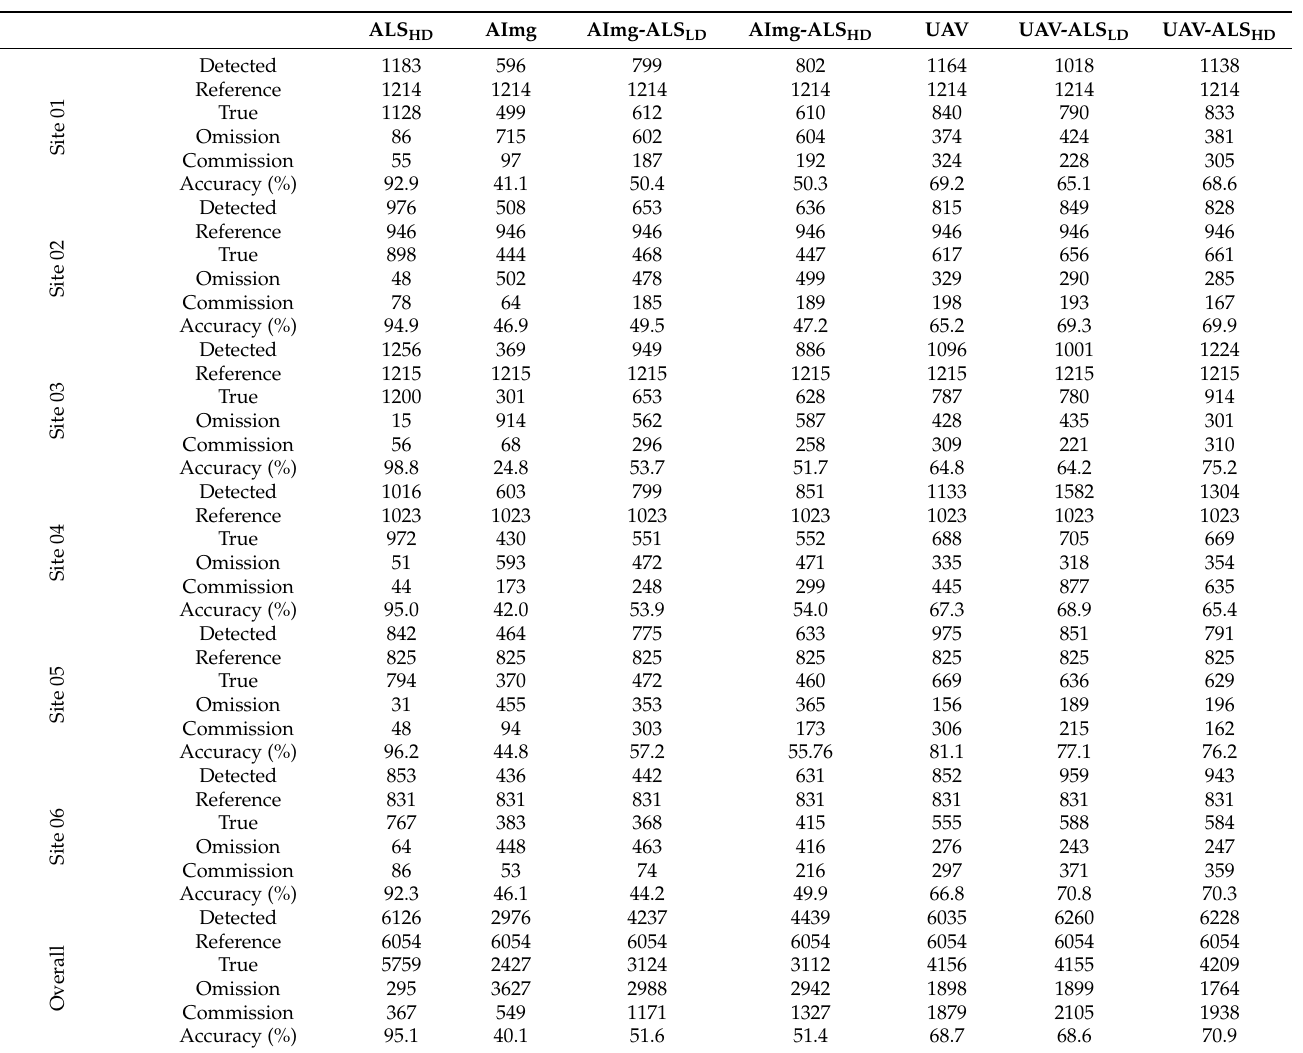
Table A1. Summary of individual tree detection (ITD) results of woody vegetation in six study